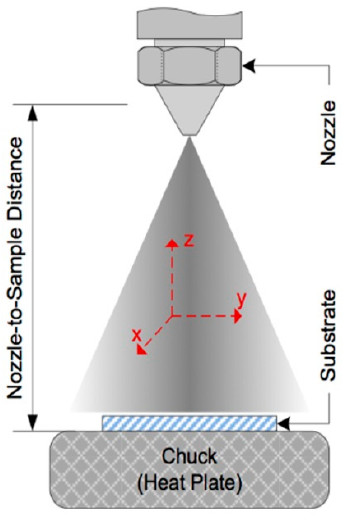
Figure 12. Schematic representation of the spraying device used by Cagatay. © 2014 IEEE. Reprinted, with permission, from [50].